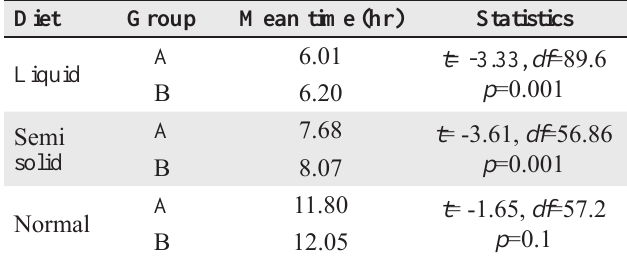
Table 3 : Time of oral intake after